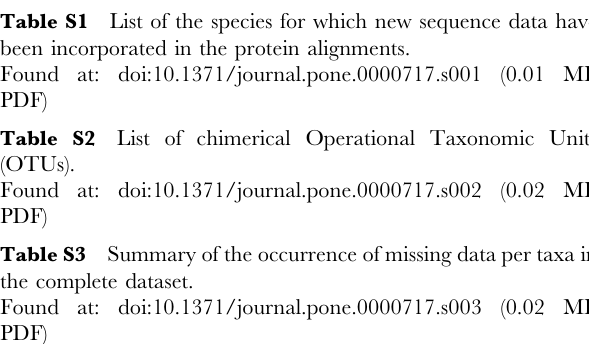
Figure S5 Bayesian tree inferred from 11,959 unambiguously aligned amino acid positions without the outgroup (Ichthyosporea, Choanoflagellata, Porifera and Cnidaria) using the CAT model. The robustness of the phylogenetic inference was estimated by 100 bootstrap replicates. Nodes supported by bootstrap values of 100% are denoted by black circles while lower values are given explicitly. The scale bar indicates the number of changes per site.